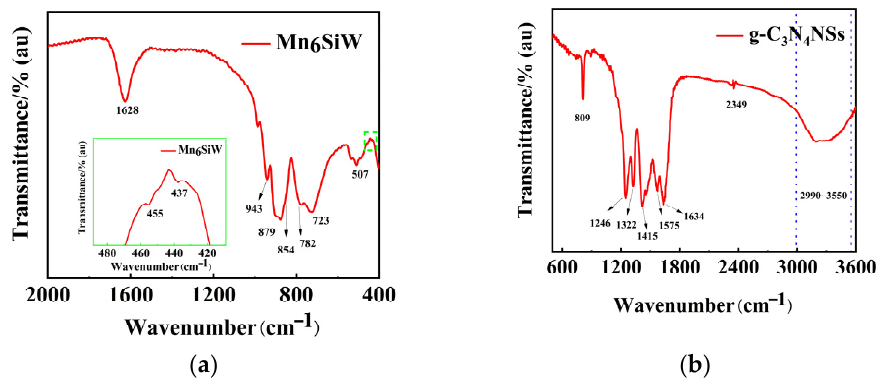
Figure 3. The IR spectra of Mn 6 SiW ( a ) and ( b ) g-C 3 N 4 NSs.